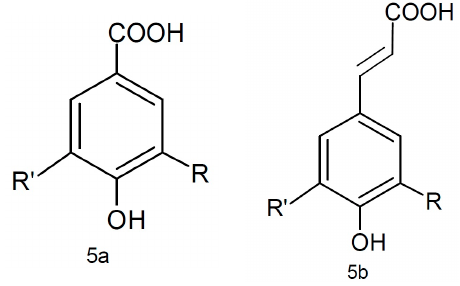
Figure 5. Non-flavonoids: benzoic (5a) and cinnamic (5b) acids.